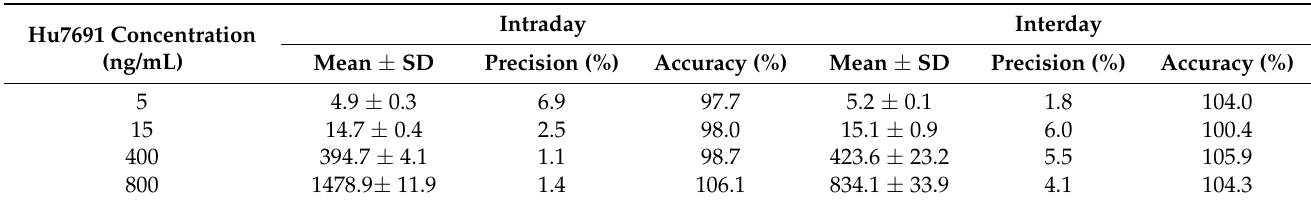
Figure 3. Linear fitting equation of the Hu7691 signal versus concentration. Table 2. Inter- and intra-assay precision and accuracy of Hu7691 in beagles (n = 5).